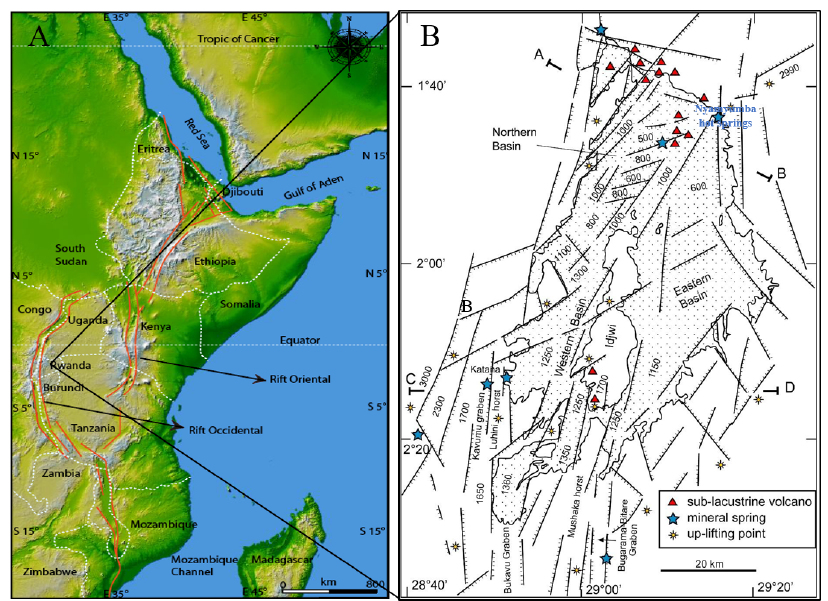
Figure 1. ( A ) Digital elevation model showing the location of the East African Rift System and Rwanda. ( B ) Structural map of the Kivu basin. A–B and C–D indicate the cross-sections. Adapted with permission from [17], 2016, Elsevier.